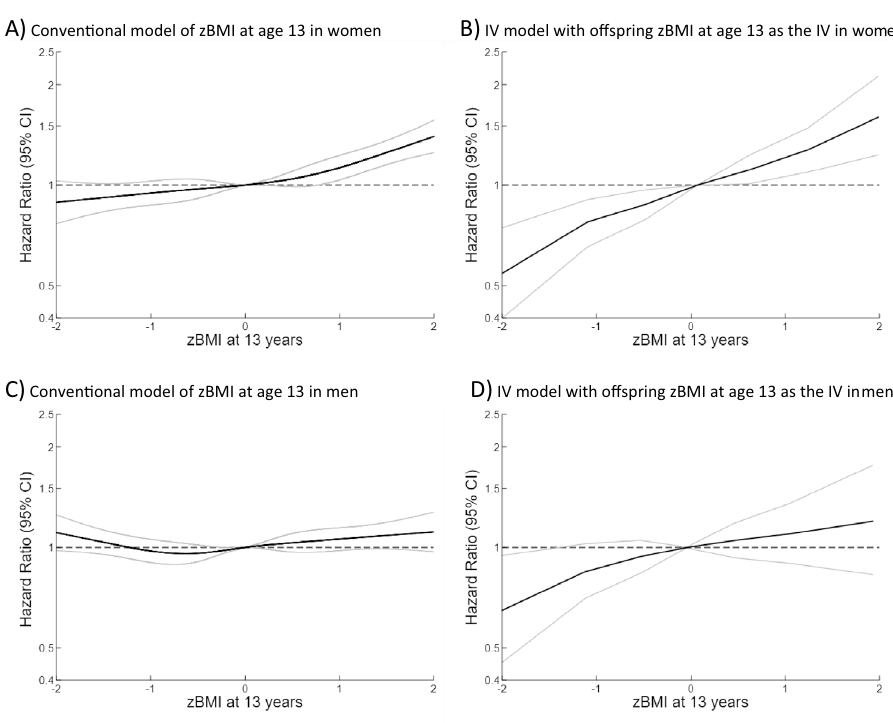
Figure 2. Association between zBMI at age 13 and all-cause mortality estimated by a conventional model and instrumental variable (IV) model. All models are adjusted for parental and offspring birth cohort, parental and offspring